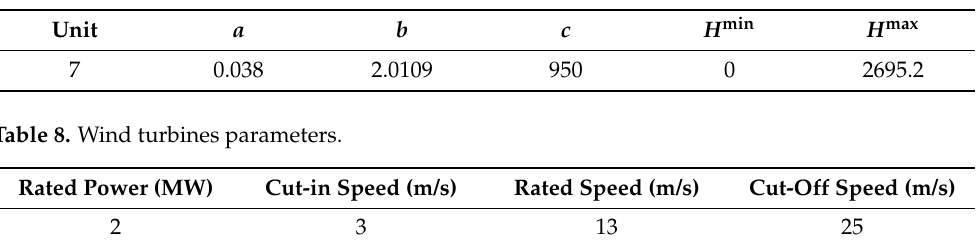
Table 7. Cost coefficients for heat-only unit.